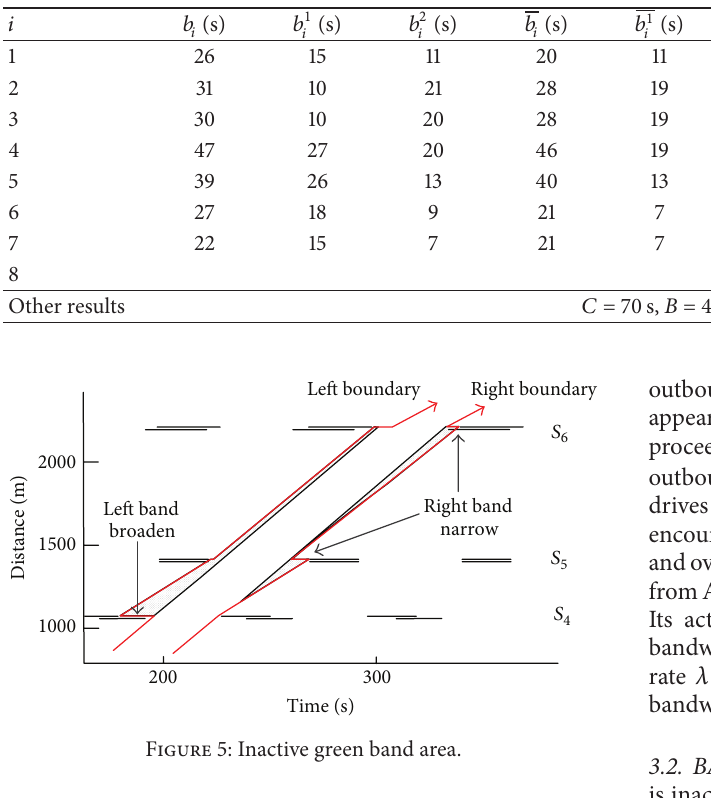
Table 1: Results from AM-BAND.